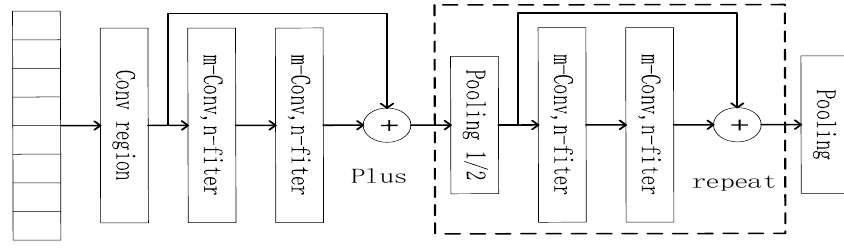
Fig. 2. DPCNN model structure diagram.